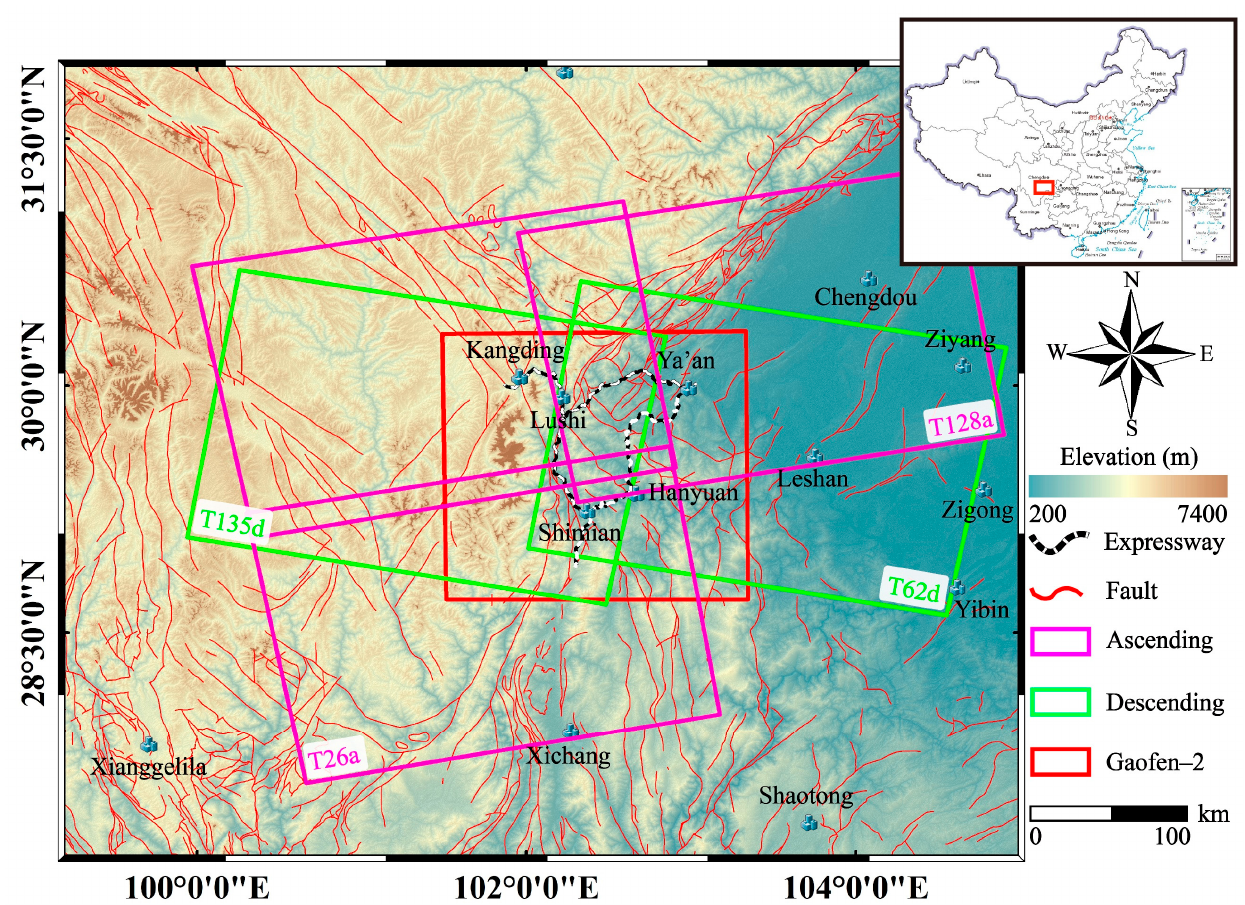
Figure 1. Location of the three expressways and coverage of image datasets. Pink rectangles indicate the coverage of Sentinel-1 ascending tracks, green rectangles show the coverage of Sentinel-1 descending tracks, and red rectangle indicates the coverage of satellite optical images. Upper right corner red rectangle indicates the location of the study area in China.